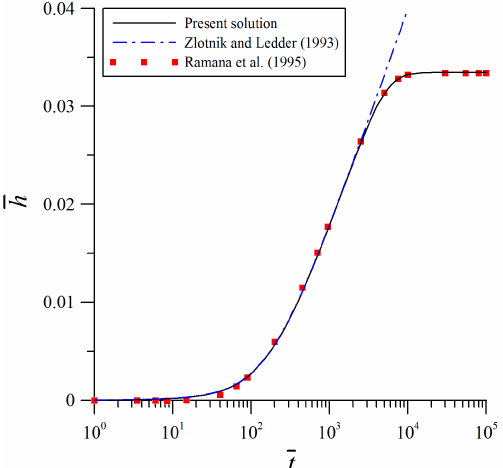
Figure 5. Temporal distributions of the dimensionless head subject to a transient recharge rate predicted by the Ramana et al. (1995) solution, the Zlotnik and Ledder (1993) solution, and the present solution with κ z = 1, κ = 100, and ε =